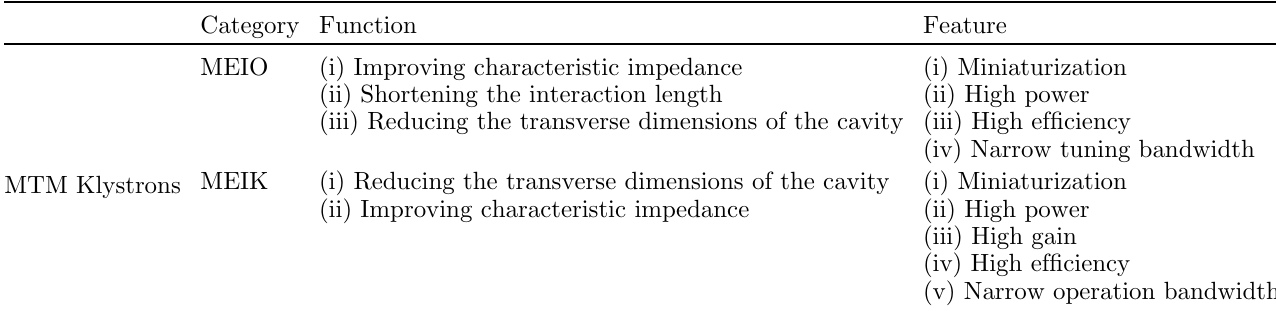
Table 1. Features of typical MTM